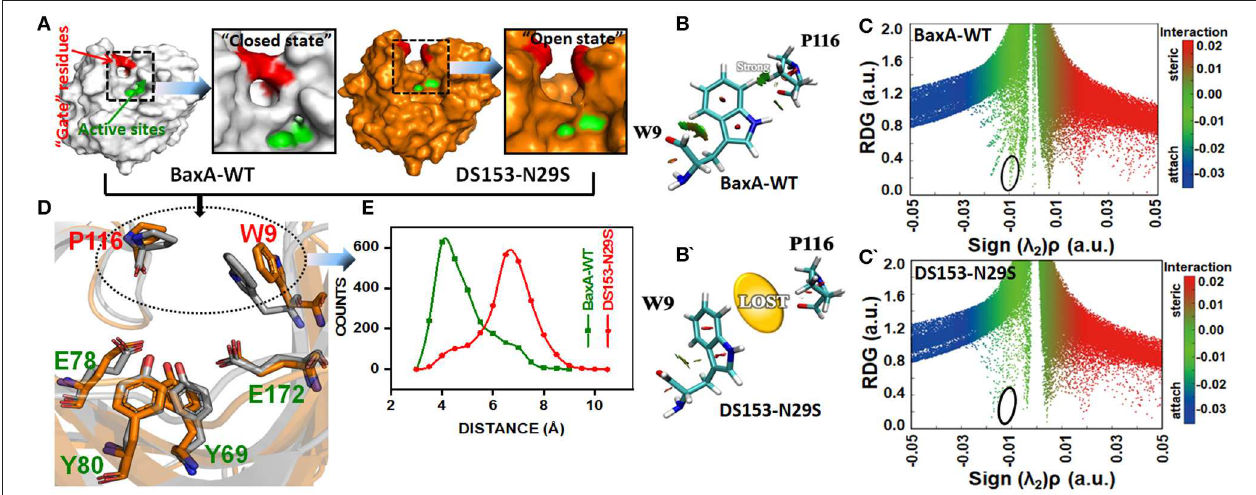
FIGURE 7 | Post-MD modeling presentation and frequency distribution of distances between “gate” residues in DS153. (A) the cartoon representation to illustrate the variation in “gate” residues (W9 and P116) in BaxA and DS153. (B,B ′ ) RDG isosurfaces for the WT and DS153 were individually plotted by using VMD 1.9.3. The green indicated van del Waals-type interactions. (C,C ′ ) color-mapped scatter map was used to facilitate identification of correspondence between spikes and RDG isosurfaces using gnuplot program. (D) The stick models represented the location of crucial “gate” residues. W9 and P116 were substrate-binding subsites and flipped open allowing the substrate access the catalytic cleft. (E) The frequency distribution of distances between P116 and W9 in DS153 and